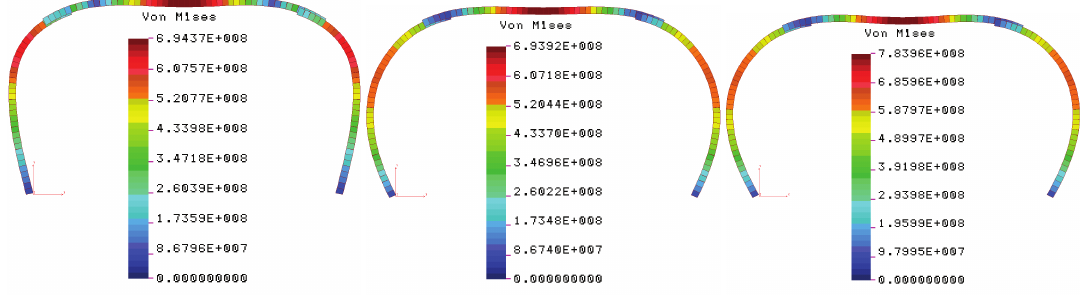
Figure 13: Map of reduced stresses in A (left), B (middle) and C (right) frames for load scheme – variant II (stresses in Pa, deformation scale 10×).